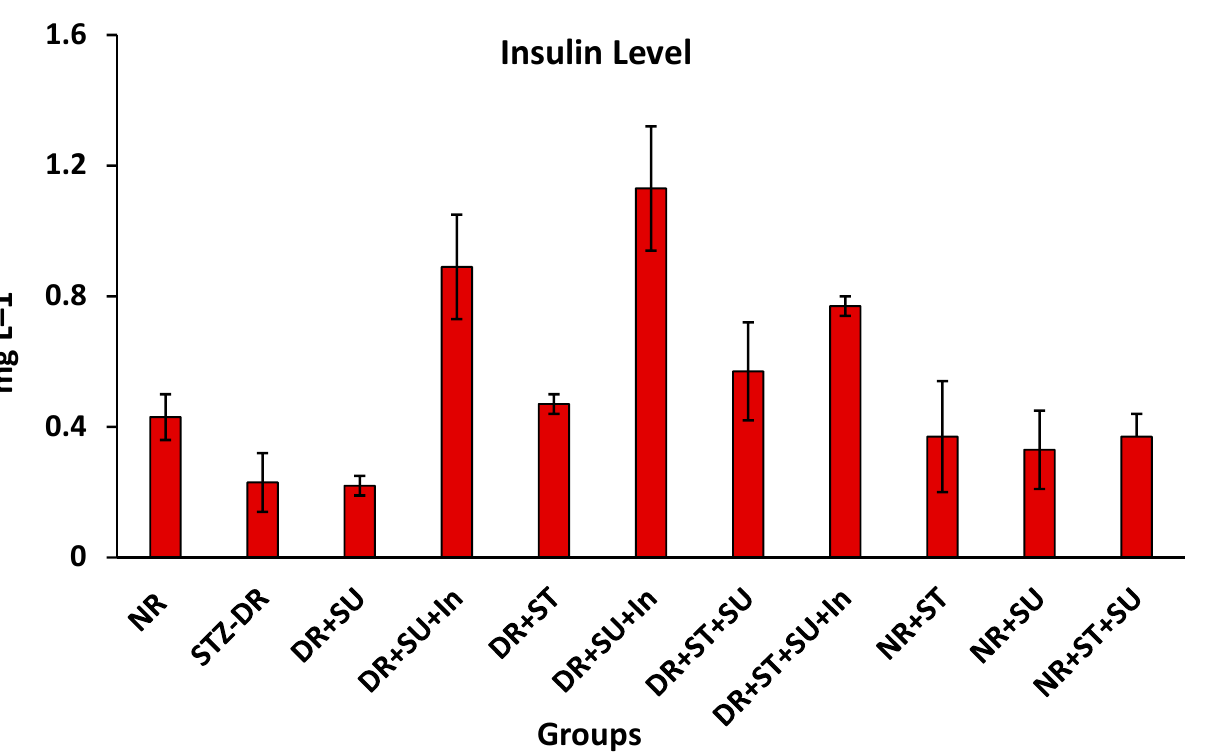
Figure 1. Effects of stevioside and sucralose and their combination on serum insulin in STZ-induced diabetes in rats. NR: normal rats, STZ-DR: STZ-diabetic rats, DR+SU: diabetic rats + SU, DR+SU+In: G3+insulin, DR+ST: diabetic rats+ST, DR+ST+In: G5+insulin, DR+ST+SU: diabetic rats+[SU+ST], DR+ST+SU+In: G7+insulin, NR+ST: G1+ST, NR+SU: G1+SU, NR+ST+SU: G1+[SU+ST].